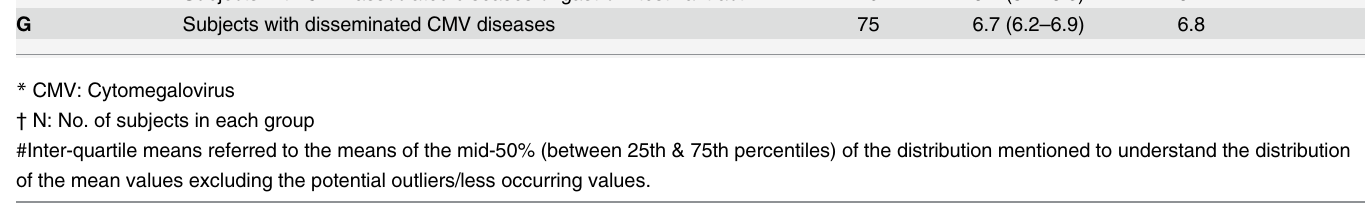
Table 3. Distribution of serum CMV * viral load amongst the subjects with varying manifestations. Group ID